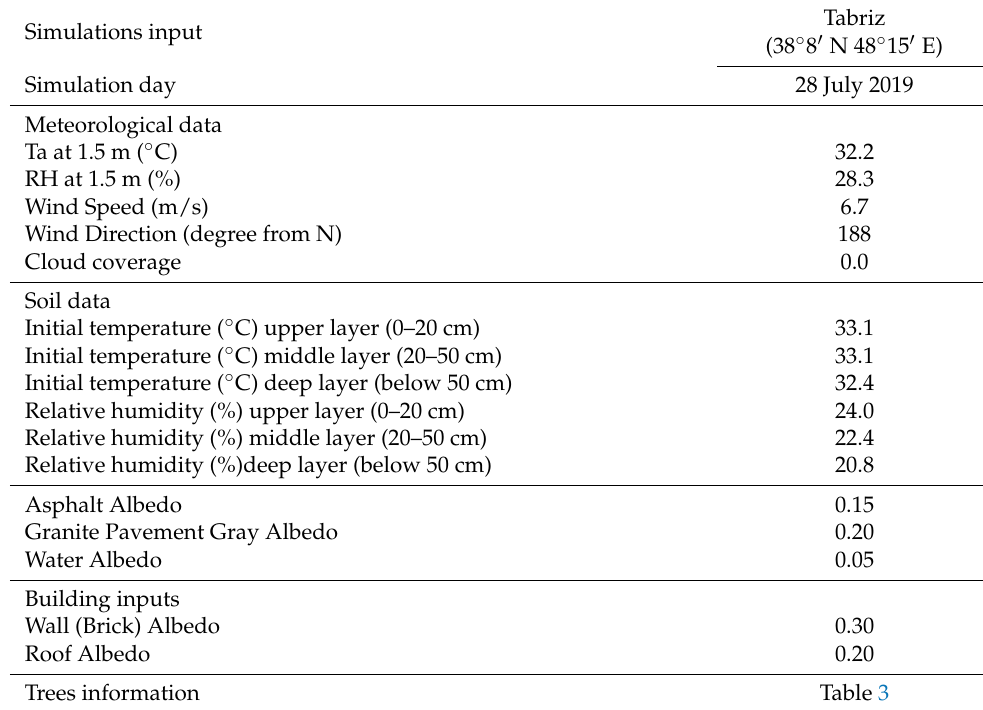
Table 2. The conditions used in the configuration file.